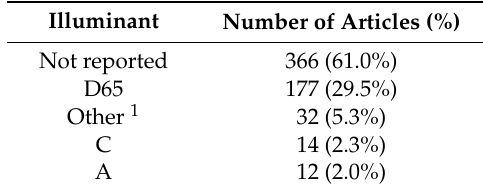
Table 4. Data for illuminant studied for measuring milk color.